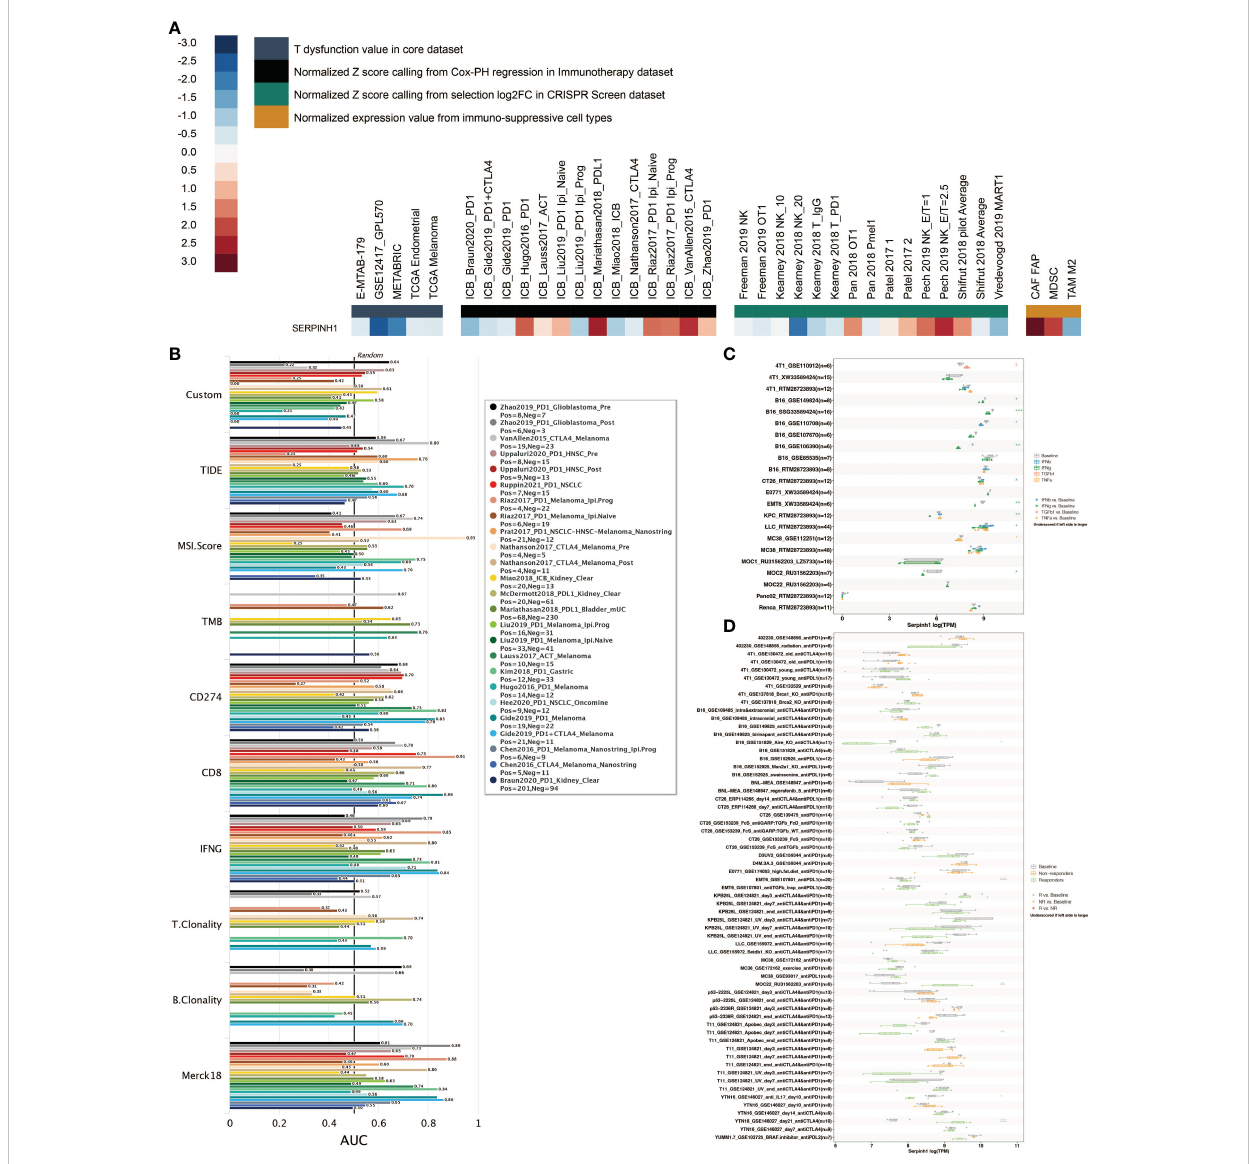
FIGURE 2 Immunotherapy prediction of SERPINH1. (A) The regulator prioritization module in TIDE. (B) Comparison of SERPINH1 and immunotherapy determinants in human immunotherapy datasets. (C) The prediction of SERPINH1 in cytokine treatment (IFN- b , IFN- g , TGF- b , and TNF- a ) in murine datasets. (D) The prediction of SERPINH1 in immunotherapy in murine datasets. *P<0.05; **P<0.01;